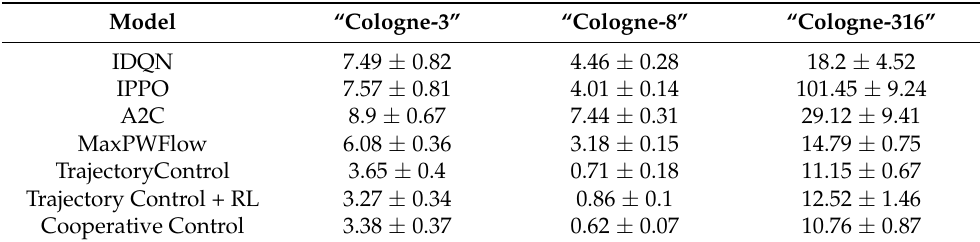
Table 4. Average stop delays (sec) for different simulation